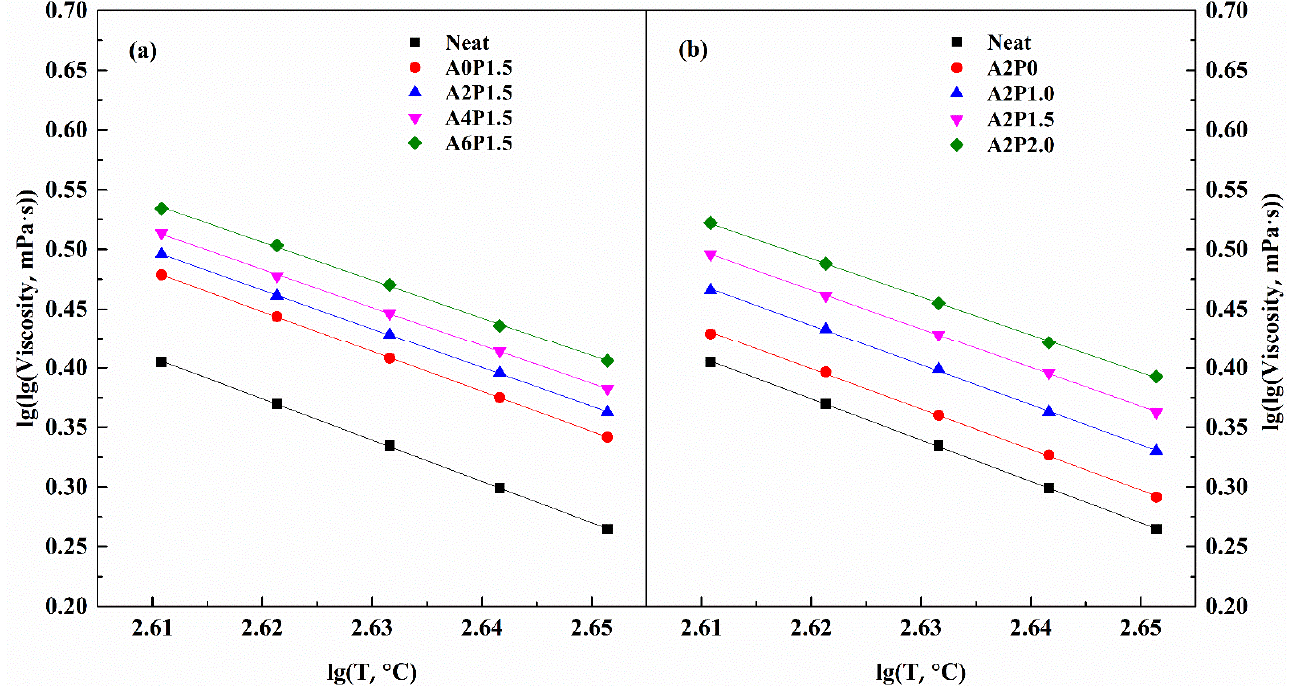
Figure 4. Viscosity − temperature relationship for composite modified binders: ( a ) composite modified binders with various contents of APAO; ( b ) composite modified binders with various contents of PPA. Table 5. The slope and intercept values of fitting curves.